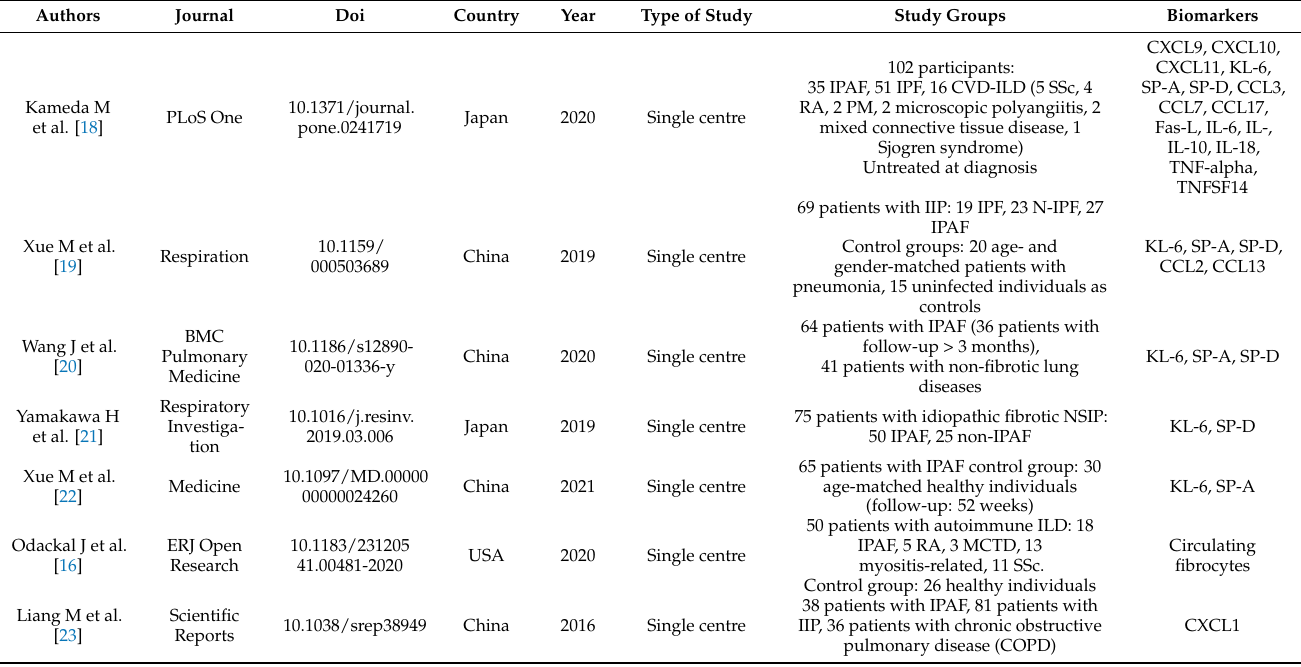
Figure 1. Flowchart of the study. Table 1. Studies included in the